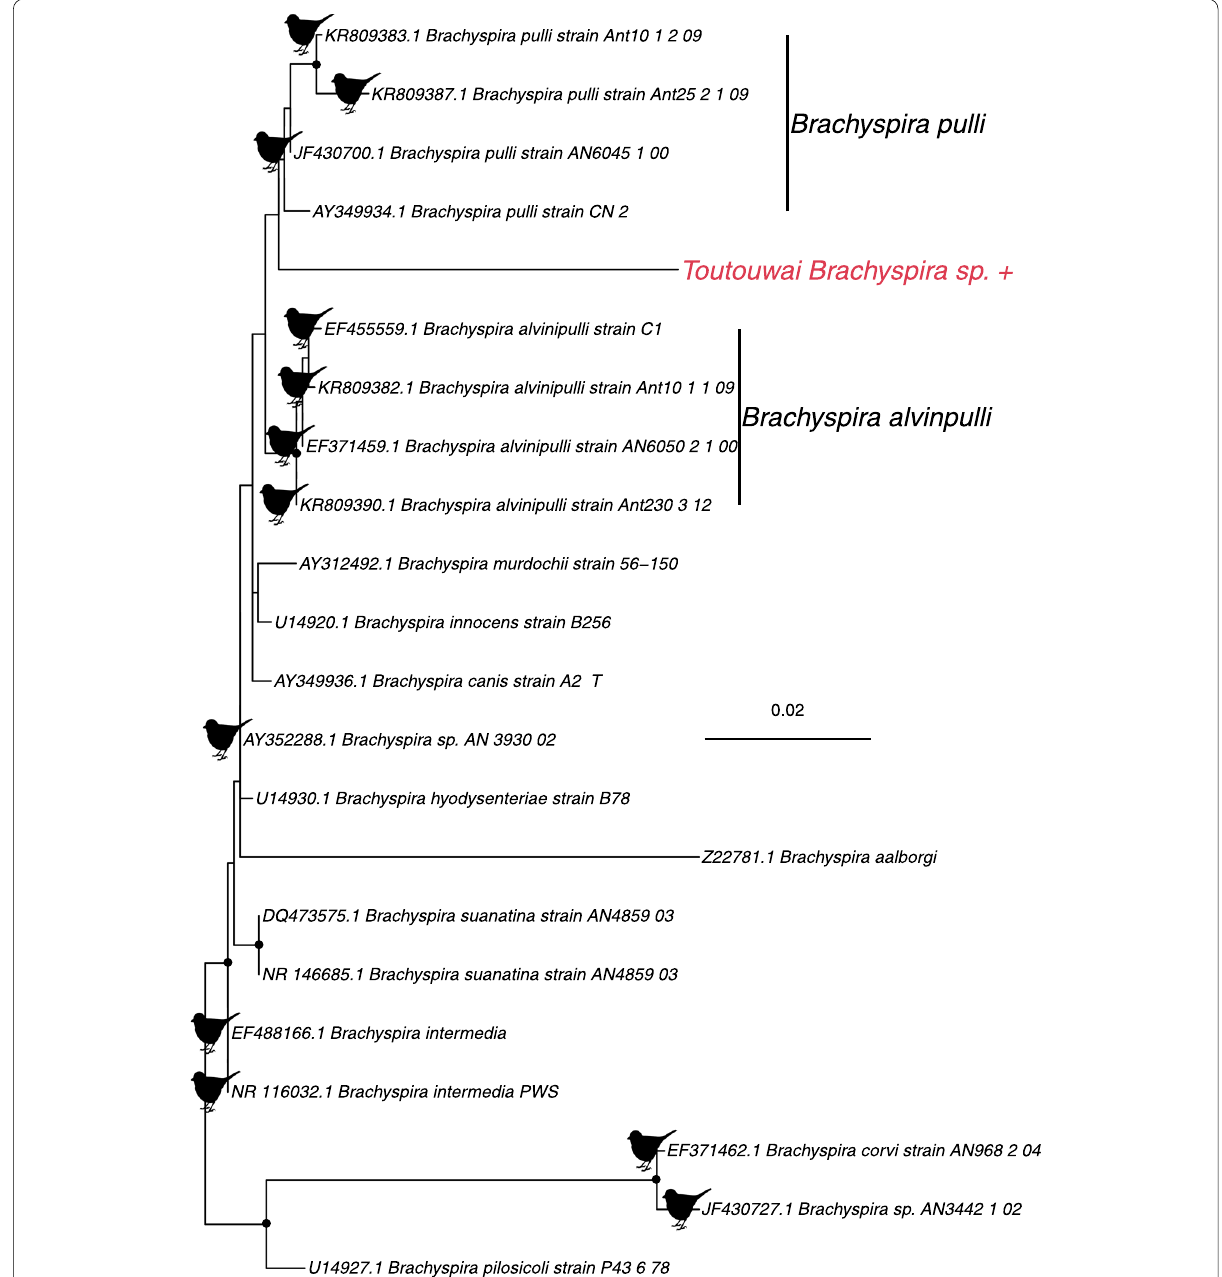
Fig. 5 Phylogeny of the bacterial genus Brachyspira , based on the 16S rRNA gene (alignment length of 1542 nucleotides). The bacterium from this study ( toutouwai Brachyspira sp.) is shown in red and has a ‘ ’ after the name. Spirochetes found in birds are marked with a bird silhouette. Black + circles on nodes show bootstrap support values of more than 90%. Branches are scaled according to the number of nucleotide substitutions per site, shown in the scale bar. The tree is midpoint rooted for purposes of clarity